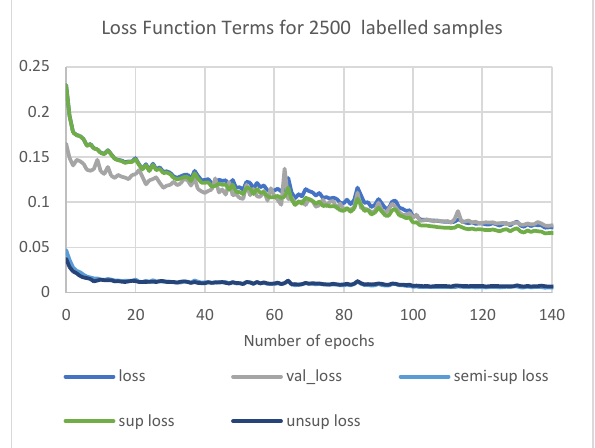
Figure 4 . Loss function terms of the semi-supervised method for 𝑆 2500 . Loss is the aggregate loss, sup loss is the supervised component of the loss function ( 𝐿 1 ), semi-sup loss is the consistency regularization term for the labelled samples ( 𝑅 1 ), and unsup loss is the consistency regularization term for the unlabelled samples ( 𝑅 2 ) of the